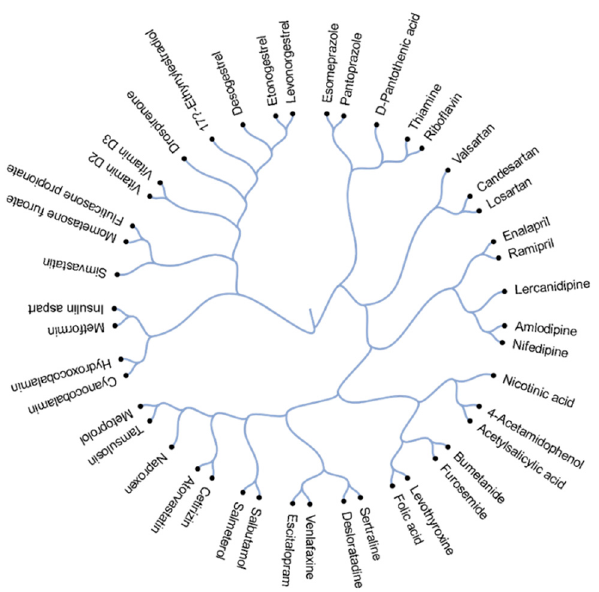
Figure 1. Active compounds of 45 most prescribed drugs clustered based on their structural similarity, calculated by ECPF4 fingerprints and the Tanimoto coefficient.